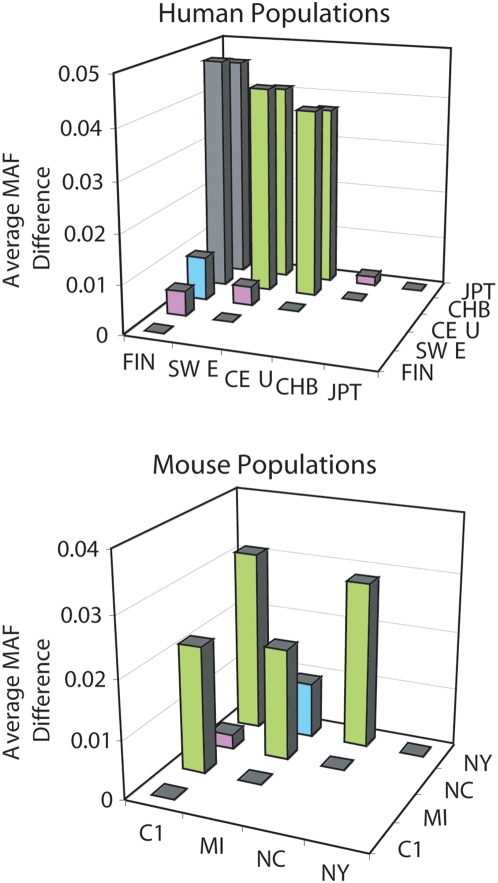
Human and mouse population comparisons.Pair-wise comparisons of average MAF differences among human founder (FIN–Finnish, SWE–Swedish) and HapMap (CEU–CEPH, CHB–Chinese, JPT–Japan) populations and CD-1 mouse populations (C1–Cohort 1, MI–Michigan, NC–North Carolina, NY–New York). Colors represent similar differences observed between pairs of human and mouse populations (purple<0.01, blue = 0.01, green>0.02).